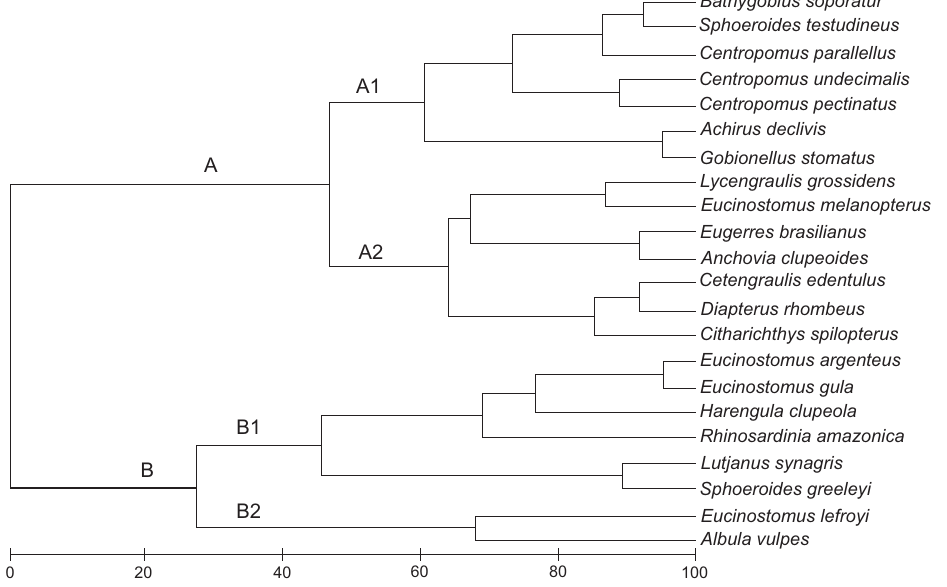
Figure 5. Most abundant species in the upper (UER), mid (MER) and lower (LER) estuarine regions of the Rio Formoso. n: number of individuals; striped column: total number of individuals; black column: average; vertical bar: standard